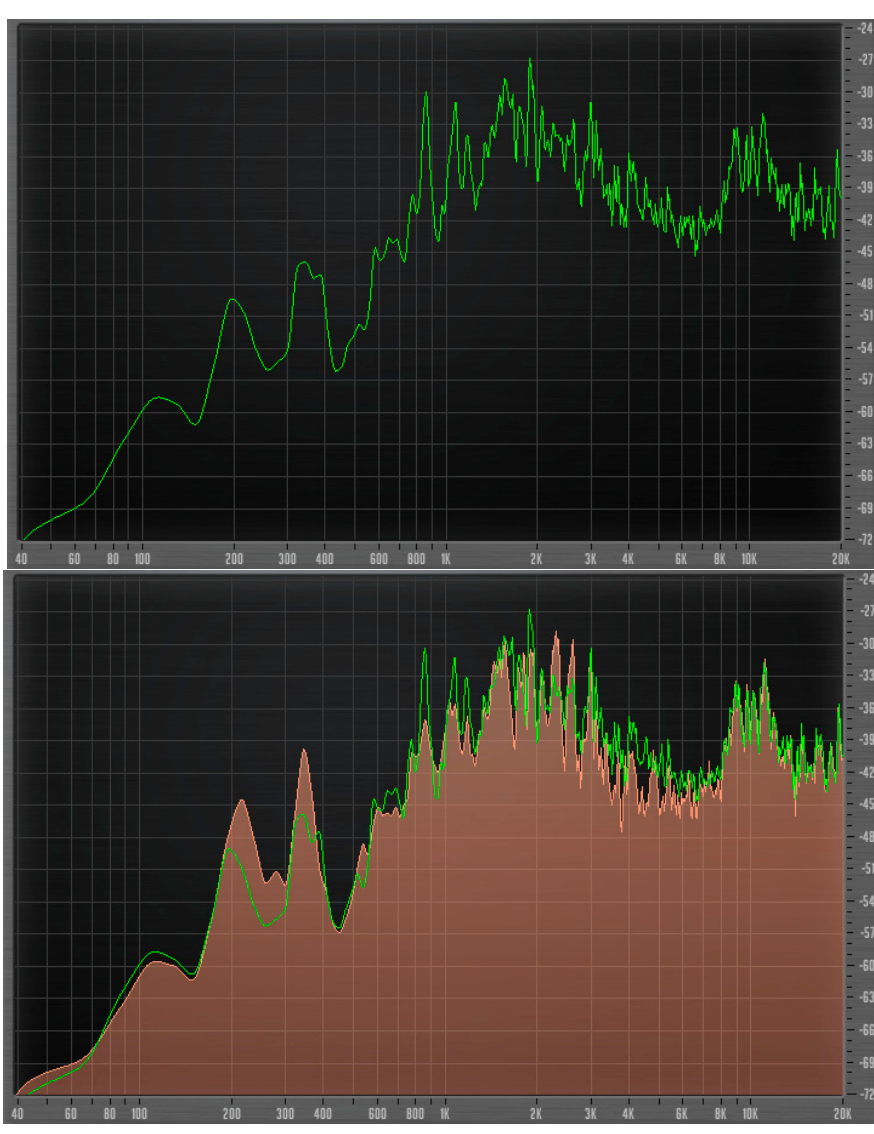
Figure 6. Amplitude and frequencies of sound at normal operating conditions ( top ); and with air intake ( bottom ). Green line—no air, red line—with air intake.